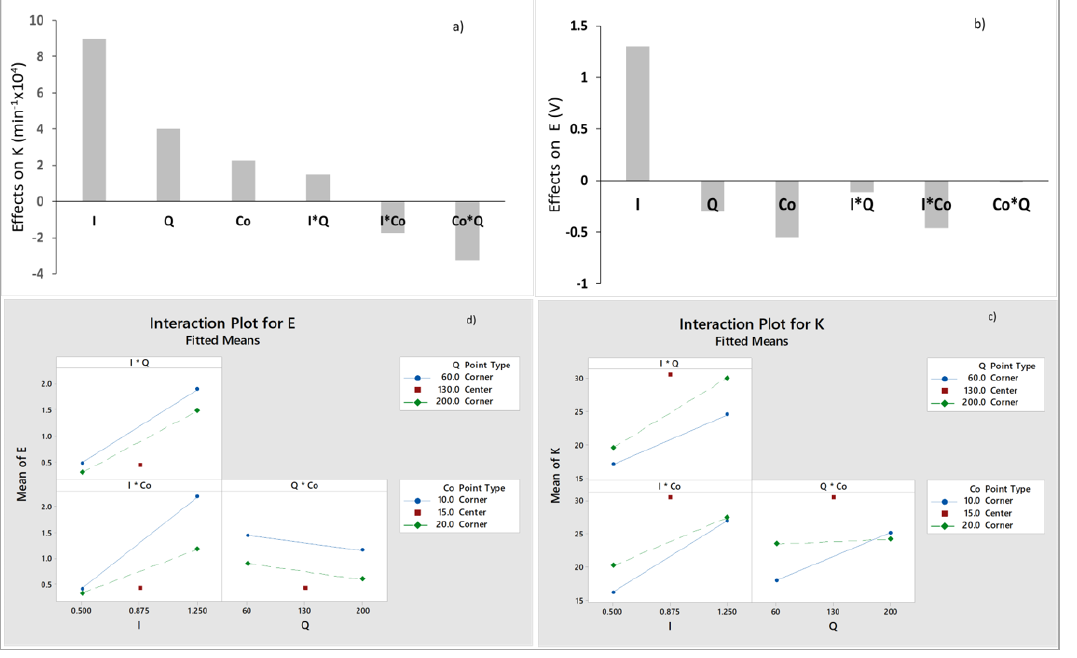
Figure 4. Comparison of single and binary effects of the different parameters on K (panel a ) and E (panel b ). Interaction plots for the binary effects on K (panel c ) and E (panel d ); the response at the central point is also reported as a comparison. (I: current, mA; Q: flow rate, mL min − 1 ; C 0 : initial DRN concentration, ppm).